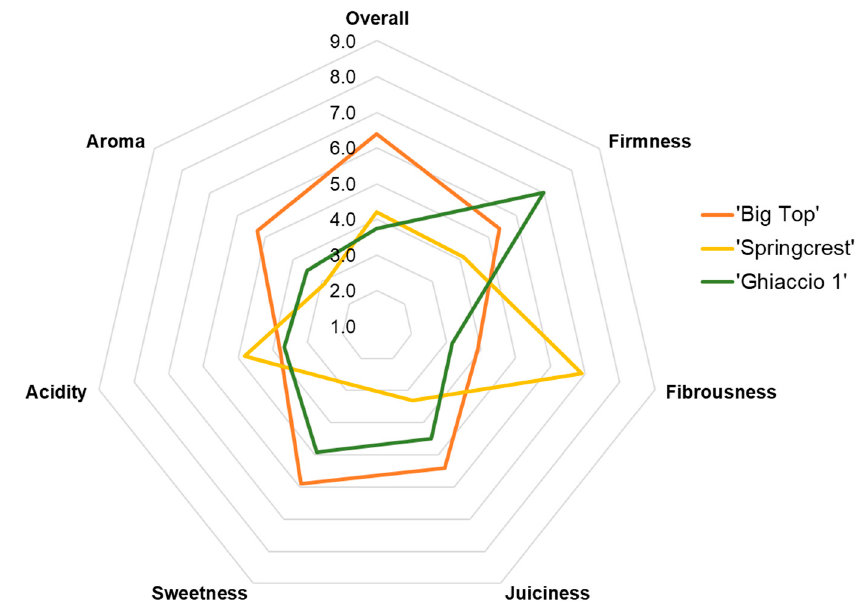
Figure 7. Radar plot of sensory evaluation survey on selected commercial cultivars assessed in 2008. Cultivars include ‘Big Top’ (slow softening, orange), ‘Springcrest’ (melting, yellow) and ‘Ghiaccio 1’ (stony hard, green). A trained panel assessed seven attributes of three commercial cultivars. Attributes assessed include the perception of firmness, fibrousness, juiciness, sweetness, acidity, aroma and an overall evaluation by panelists. The values ranged from 1 (low and dislike) to 9 (high and extremely like). The averages for each cultivar’s evaluation are displayed.